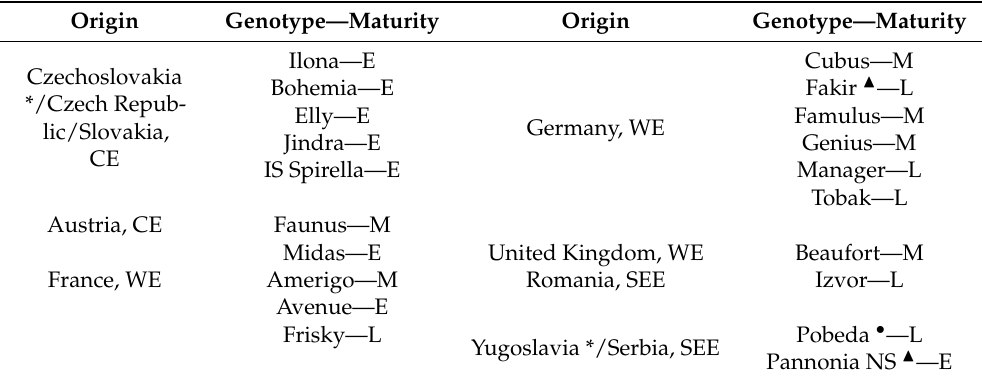
Table 1. List of genotypes by origin, time to maturity, and apparent tolerance to drought stress. Origin